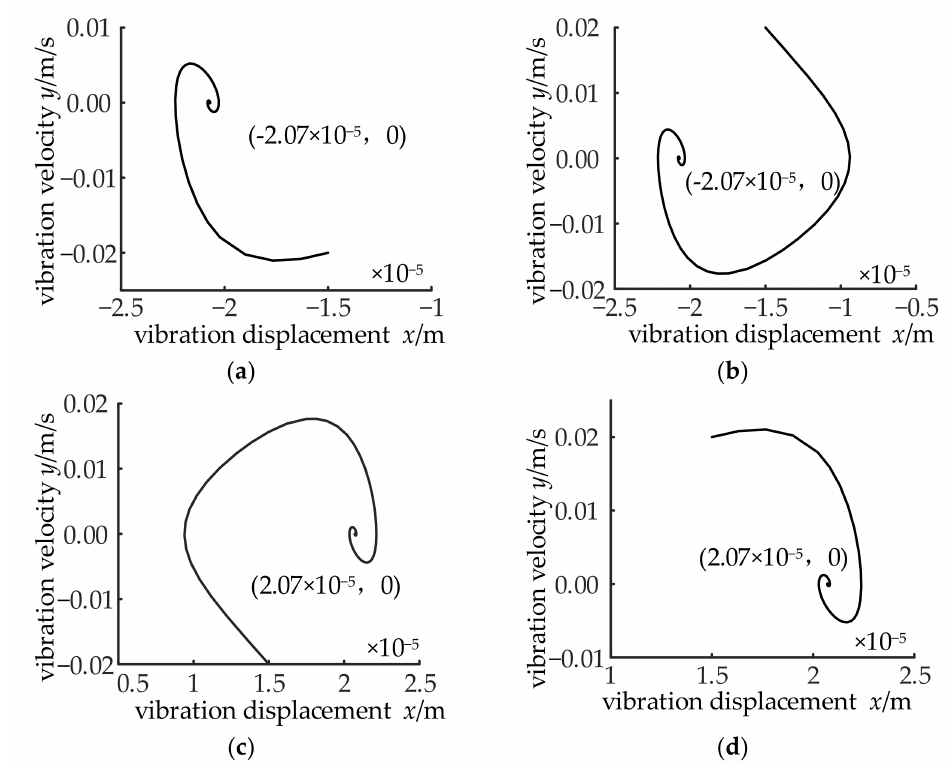
Figure 10. Phase trajectories when K p = 70. ( a ) ( − 1.5 × 10 − 5 , − 0.02). ( b ) ( − 1.5 × 10 − 5 , 0.02). ( c ) (1.5 × 10 − 5 , − 0.02). ( d ) (1.5 × 10 − 5 , 0.02).